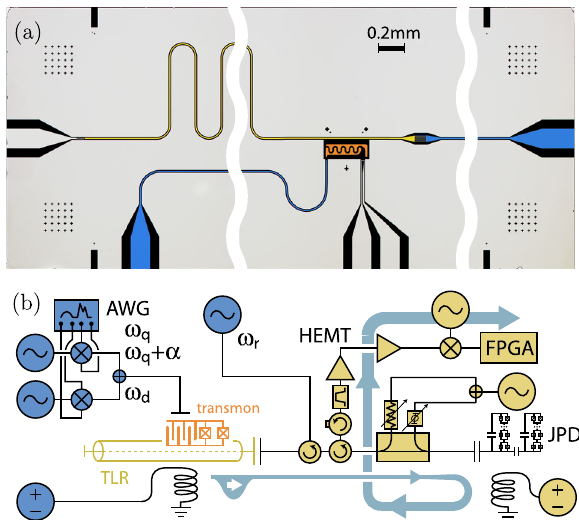
FIG. 5. (a) A false color microscope image of the chip showing the transmission line resonator coupled to the transmon circuit (rectangular structure in the middle) and the microwave control lines: the resonator input/output port, the transmon charge line (blue), and the unused flux line (gray). (b) Schematic of the measurements setup (see Appendix A). The control electronics is shown in blue, the measurement chain in yellow, and the transmon circuit coupled to the transmission line resonator (TLR) in